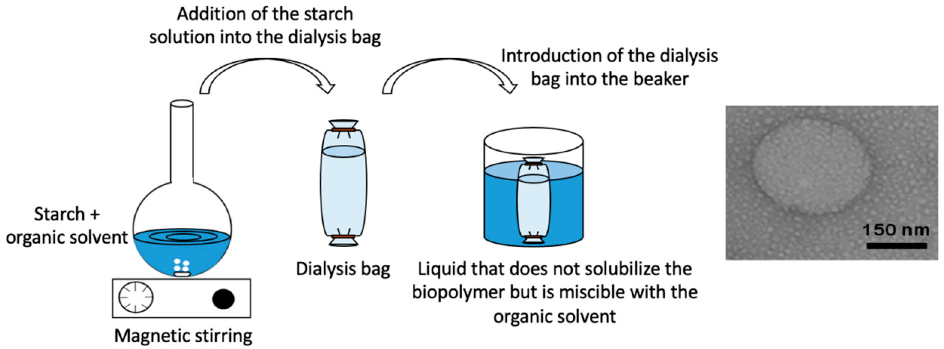
Figure 5. Synthesis of SNPs through dialysis method and TEM micrograph of potato SNPs [39].